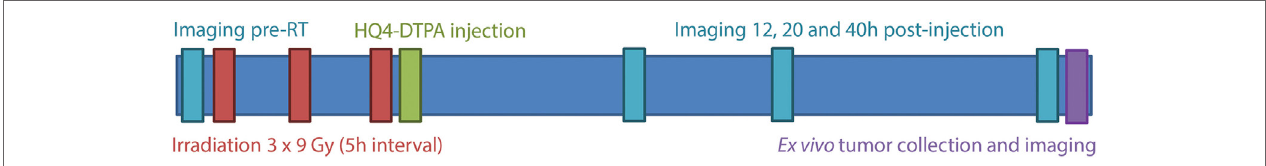
FigUre 1 | experimental schedule . Three fractions of 9 Gy irradiation were delivered with a 5-h interval and HQ4-DTPA was injected at the end of the irradiation schedule. In vivo photoacoustic and fluorescence imaging were performed at 12, 20, and 40 h following the